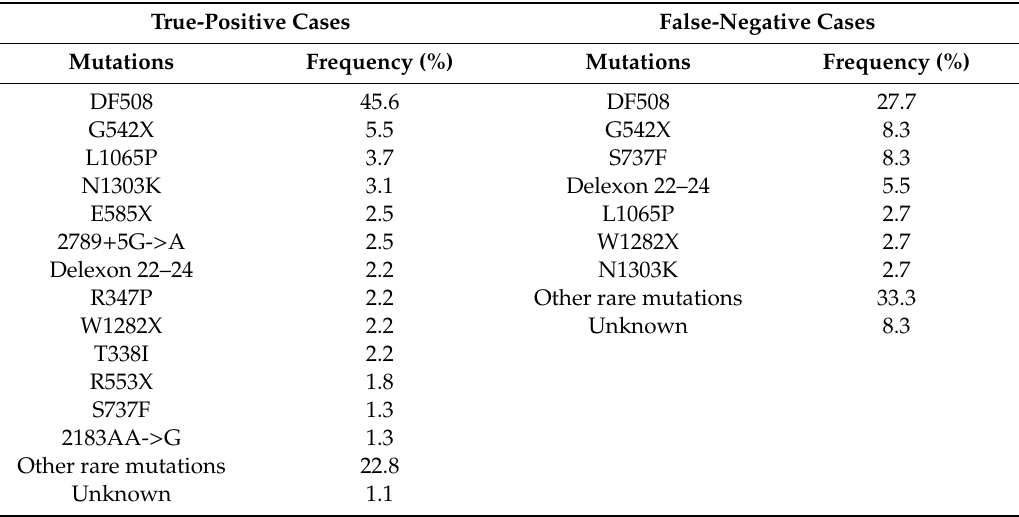
Table 3. Frequencies of CFTR mutations in 360 cystic fibrosis CFTR alleles in Tuscany (324 CFTR alleles of true positive cases and 36 CFTR alleles of